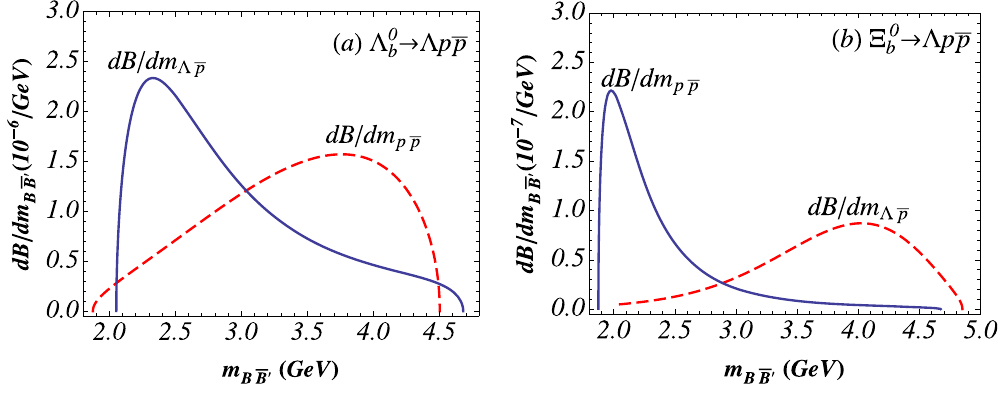
0 and ( b ) pp 0 Ξ → Λ decays. b b